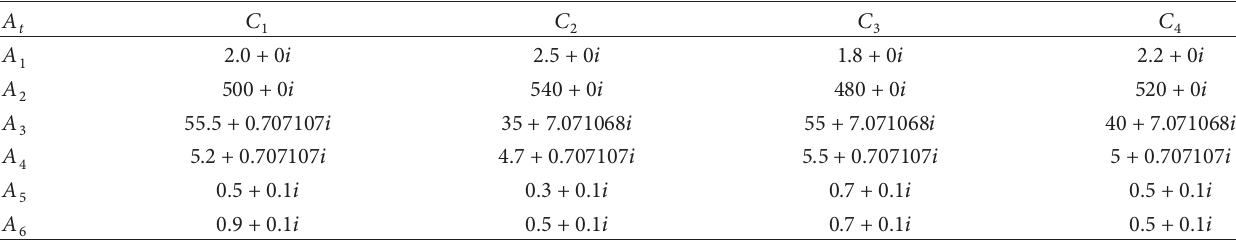
Table 3: The binary connection numbers transformed from all index values.